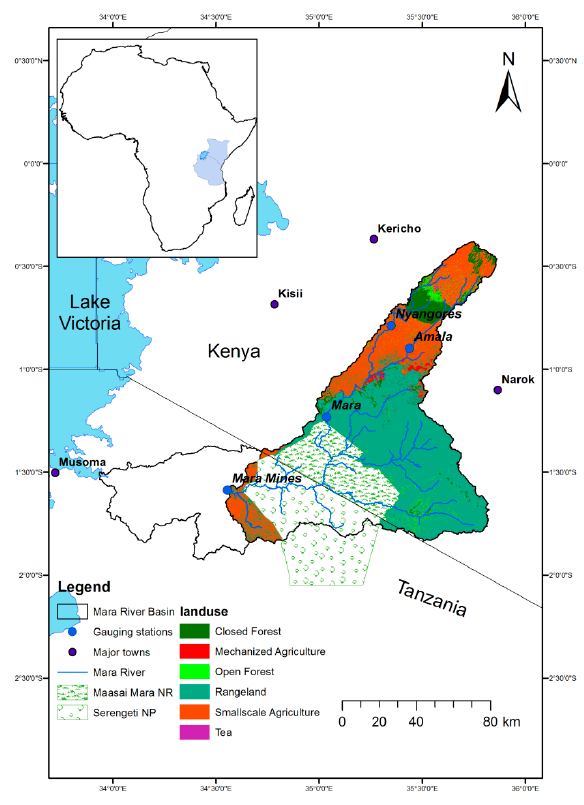
Figure 1. Mara River Basin in East Africa with major categories of land use.